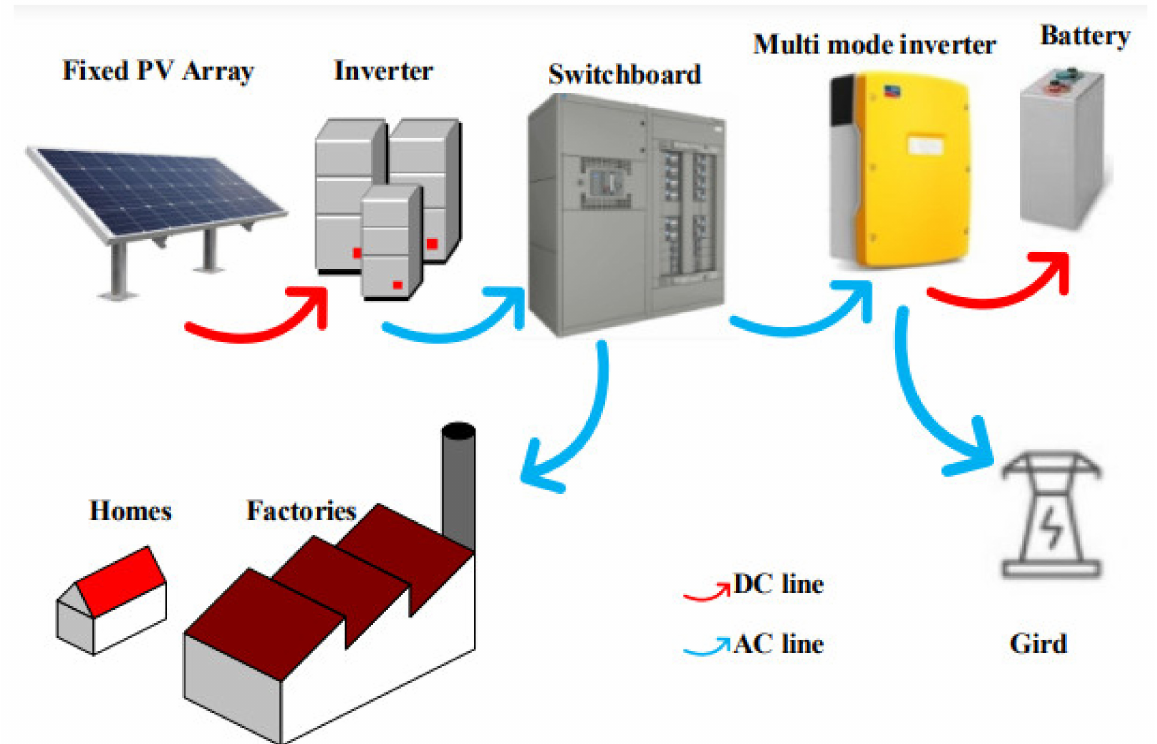
Figure 4. Basic Schematic of a PV system